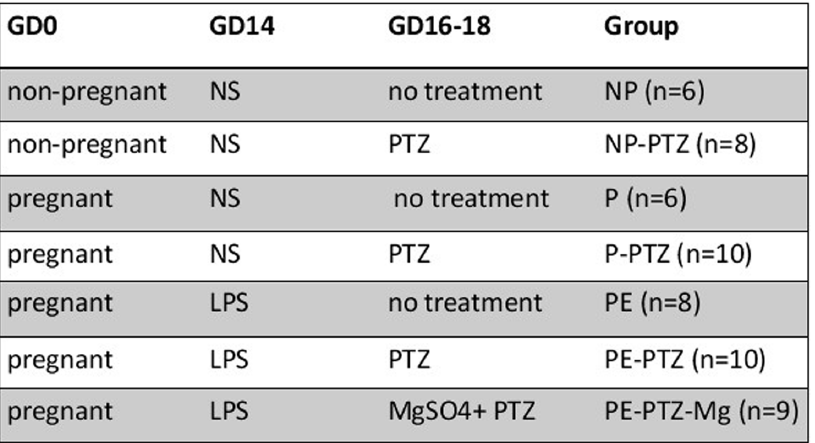
Figure 1. Study design. 57 Sprague-Dawley rats were randomly divided into seven groups designated: On gestational day 14, LPS was given to the rats comprising the preeclampsia model, while rats in the control group were given normal saline. 40 mg/kg PTZ was given on GD16–18 (i.p.) to induce seizure. Magnesium sulfate (MgSO 4 ) was given 20 minutes prior to receiving PTZ. NP=non-pregnant control (n =6); NP-PTZ=non-pregnant rats + PTZ (n =8); P=normal-pregnant control (n =6); P-PTZ=normal-pregnant + PTZ (n =10); PE=preeclampsia rats (n =8); PE-PTZ=preeclampsia